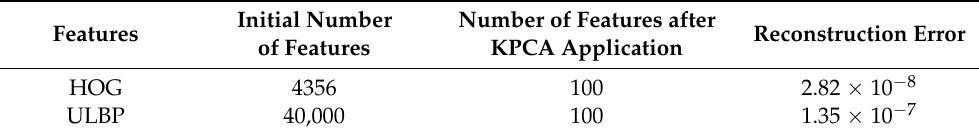
Table 2. Reconstruction error of HOG and ULBP features using